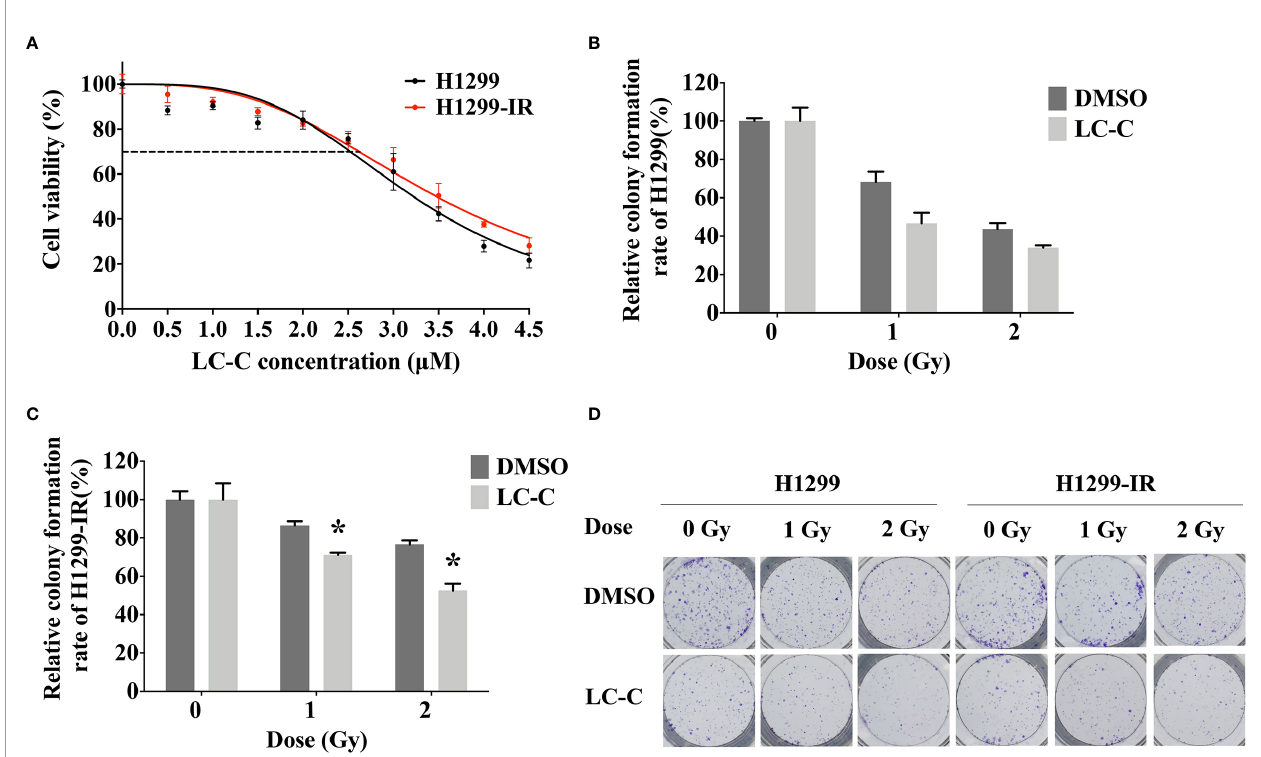
FIGURE 2 | LC-C signi fi cantly enhances the radiosensitivity of H1299-IR cells. (A) MTT assay showing the IC 30 dose of LC-C in H1299 and H1299-IR cells was about 2.5 m M to 3 m M. (B) H1299 cells were pretreated with LC-C (2.5 m M) or DMSO as control for 24 h and were then exposed to the indicated dose of radiation. Colony formation assay showed that H1299 cells were sensitive to radiation, and there was no obvious radio-sensitization effect of LC-C on H1299 cells. (C) H1299- IR cells were pretreated with LC-C (2.5 m M) or DMSO as control for 24 h and were then exposed to the indicated dose of radiation. Colony formation assay showed that LC-C signi fi cantly radiosensitized H1299-IR cells as SF2 reduced from 0.77 ± 0.02 to 0.53± 0.04. (D) Representative images showing the colony formation of H1299 and H1299-IR cells. Results shown are the means ± standard deviation. *Signi fi cant difference at P < 0.05